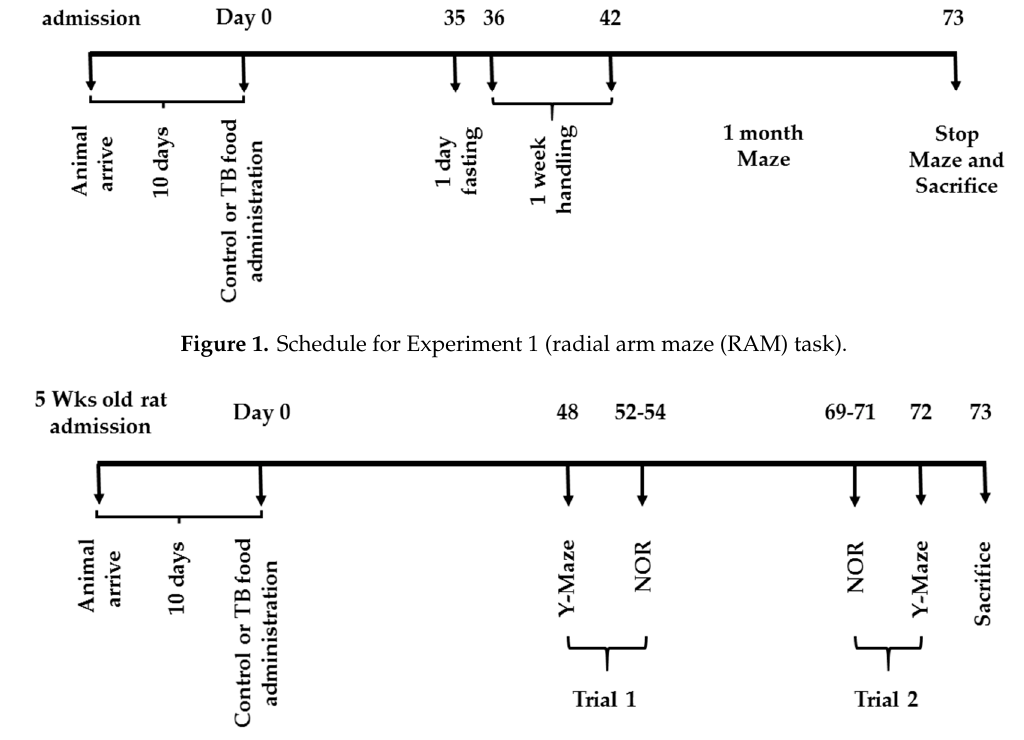
Figure 2. Schedule for Experiment 2 (Y-maze test and novel object recognition (NOR) test).